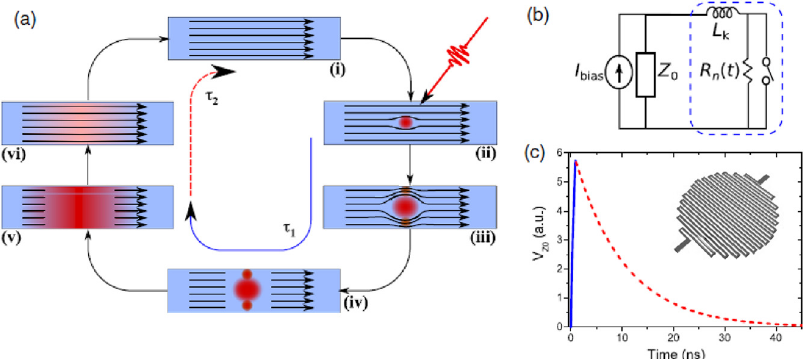
Figure 3: (a) Schematic of the detection cycle; (b) a simplified circuit model of an SNSPD; and (c) the output signal of an SNSPD upon a detection event [31]. The inset added to the original reference is a schematic of a meandered